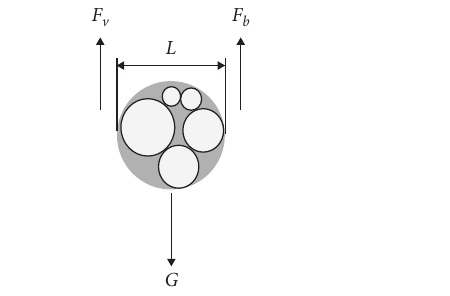
Figure 2: Force analysis of flocculation